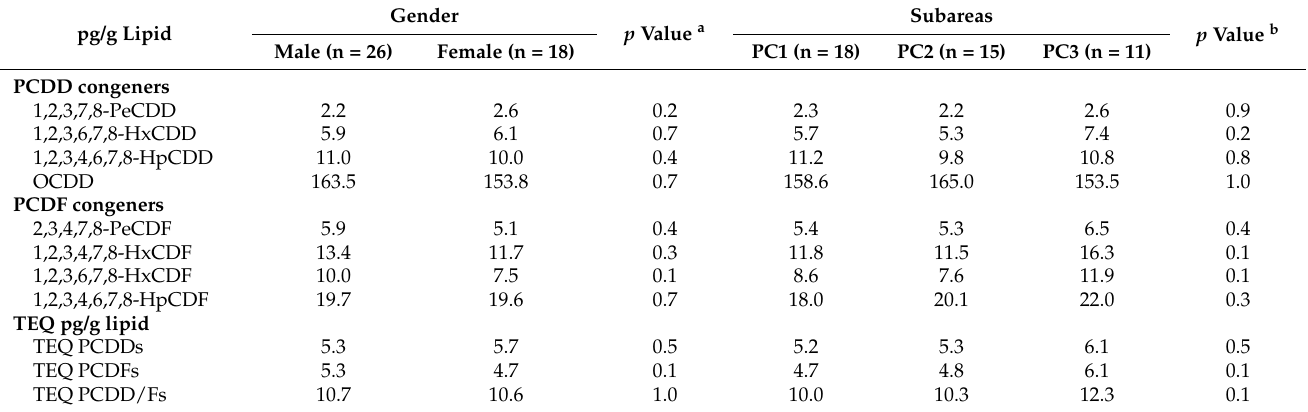
Table 2. Geometric mean of dioxin levels in hotspot divided by gender and three